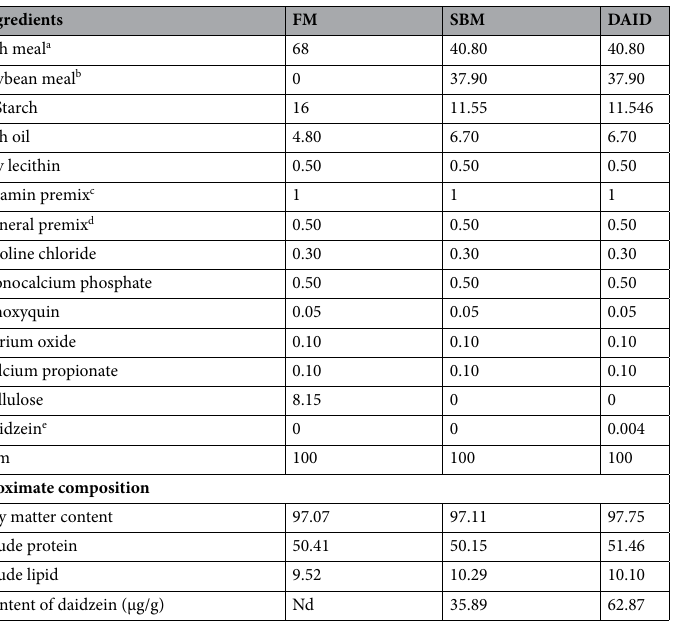
Table 2. Formulation and proximate composition of the experimental diets (% dry matter basis). FM fish meal diet, SBM soybean meal diet, DAID 40 mg/kg daidzein included into SBM diet, Nd no detected. a,b Purchased from Qingdao Seven Great Bio-tech Company Limited (Qingdao, China), Fish meal: crude protein, 74.04%; crude lipid, 9.97%; Soybean meal: crude protein, 53.12%; crude lipid: 2.12%. c Vitamin mixture (mg kg −1 ): VA, 32; VB1, 25; VB2, 45; VB6, 20; VB12, 10; Niacinaminde, 200; Inositol, 800; Calcium pantothenate, 60; VH, 60; Folate, 20; VE, 240; VK, 10; VC phosphate, 2000; VD, 5; Antioxidant, 3; Microcrystalline cellulose, 6470. d Mineral mixture (mg kg −1 ): Mg, 313; Fe, 79.10; Zn, 62.60; Mn, 46.60; I, 2; Se, 0.90; Cu, 6.40; Zeolite powder, 3485. e Purchased from Shanghai Macklin Biochemical Technology Co., Ltd., the purity was more